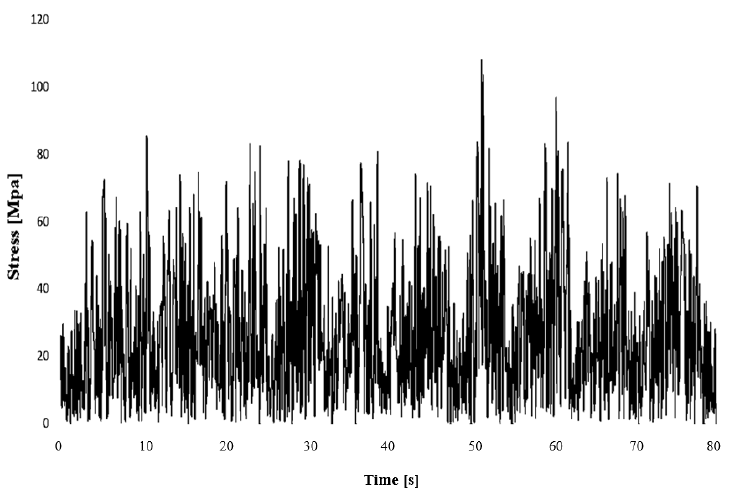
Figure 10. The von Misses equivalent stress-time diagram of one plane in the critical region, as a representative result.